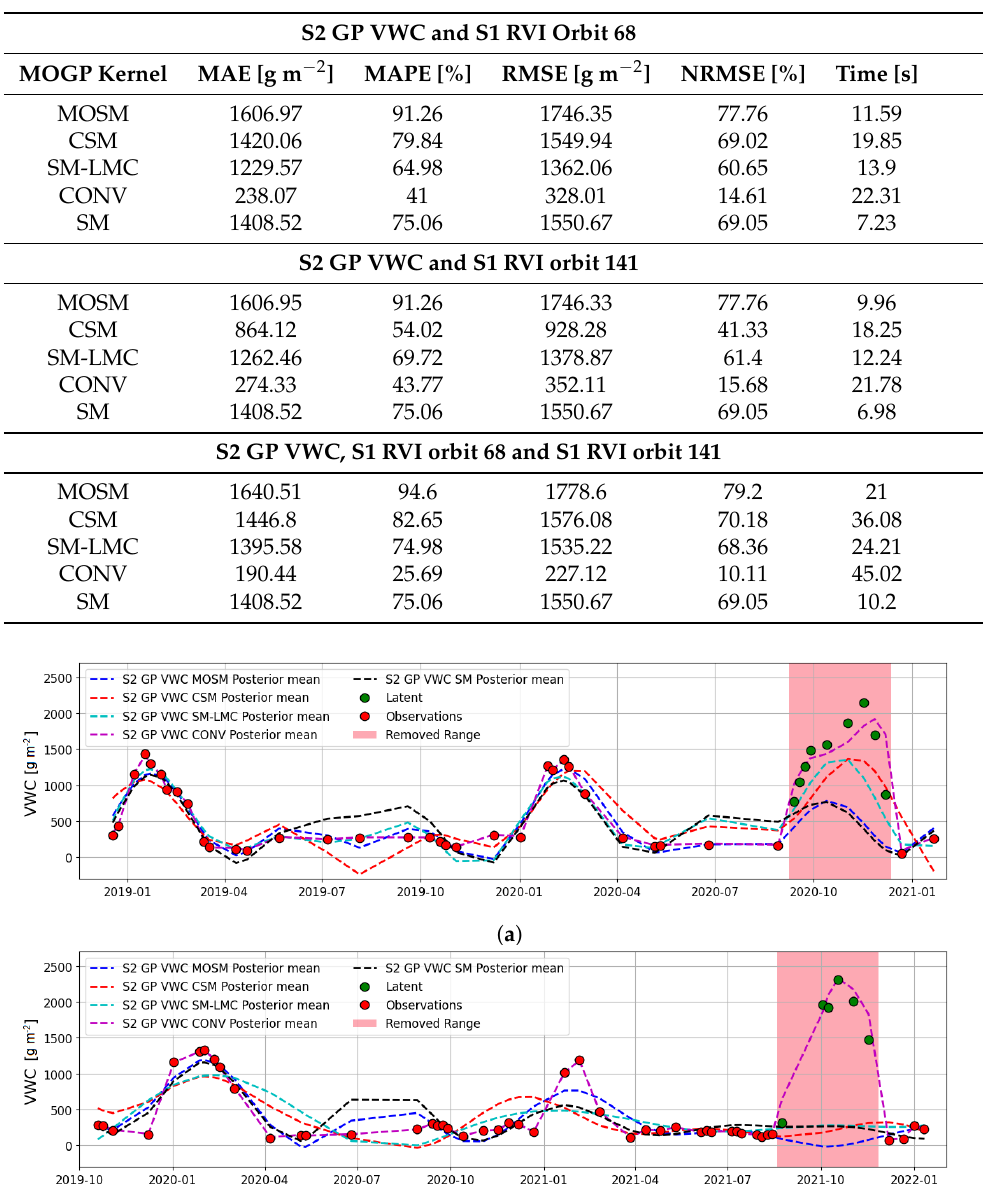
Table 3. Error metrics and training time of the MOGP and SOGP evaluated kernels for the 2021 winter wheat averaged ROI-2.